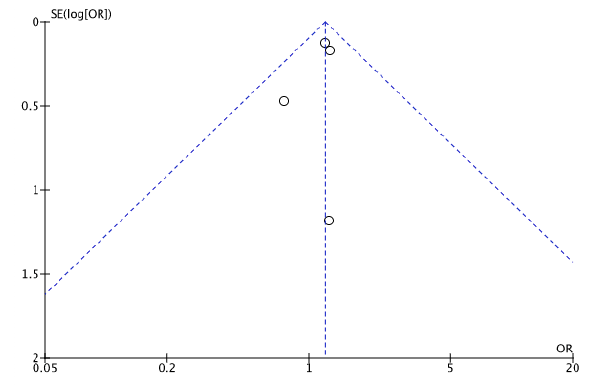
Figure B1. Overall Survival Funnel Plot. Figure A1. Overall Survival Funnel